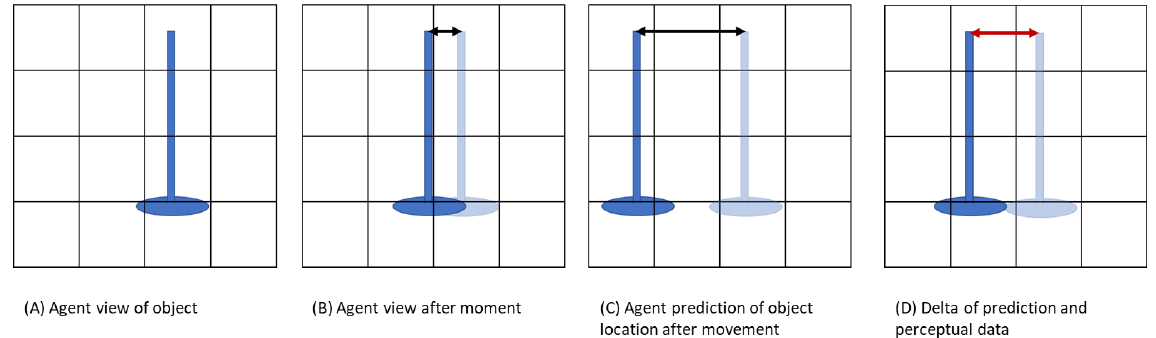
Figure 16. Figure showing the adjustment as the agent moves.